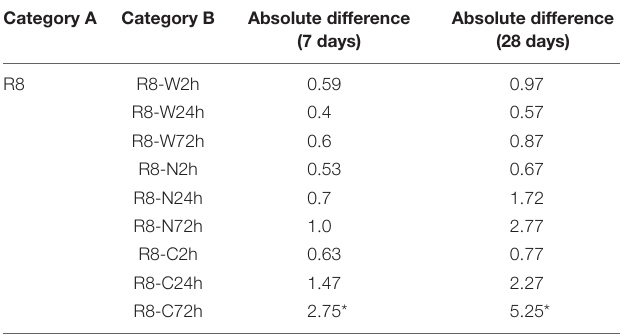
TABLE 2 | Post Hoc Tukey-Kramer analysis results.